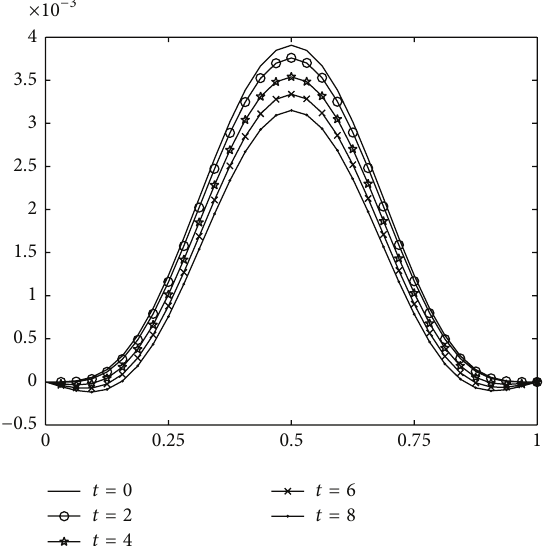
Figure 7: Numerical solutions at different time with ℎ = 1/32 , 𝜏 = 0.1 , 𝛽 = 1 , 𝛼 = 4 , and 𝑝 = 4